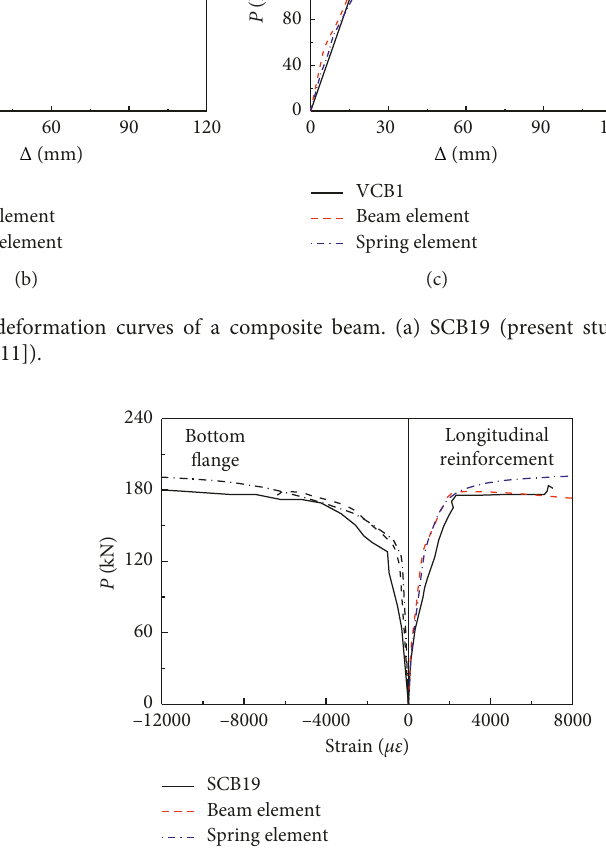
Figure 11: Comparison between the calculated and tested longitu- dinal reinforcement and bottom flange strains of a composite beam.